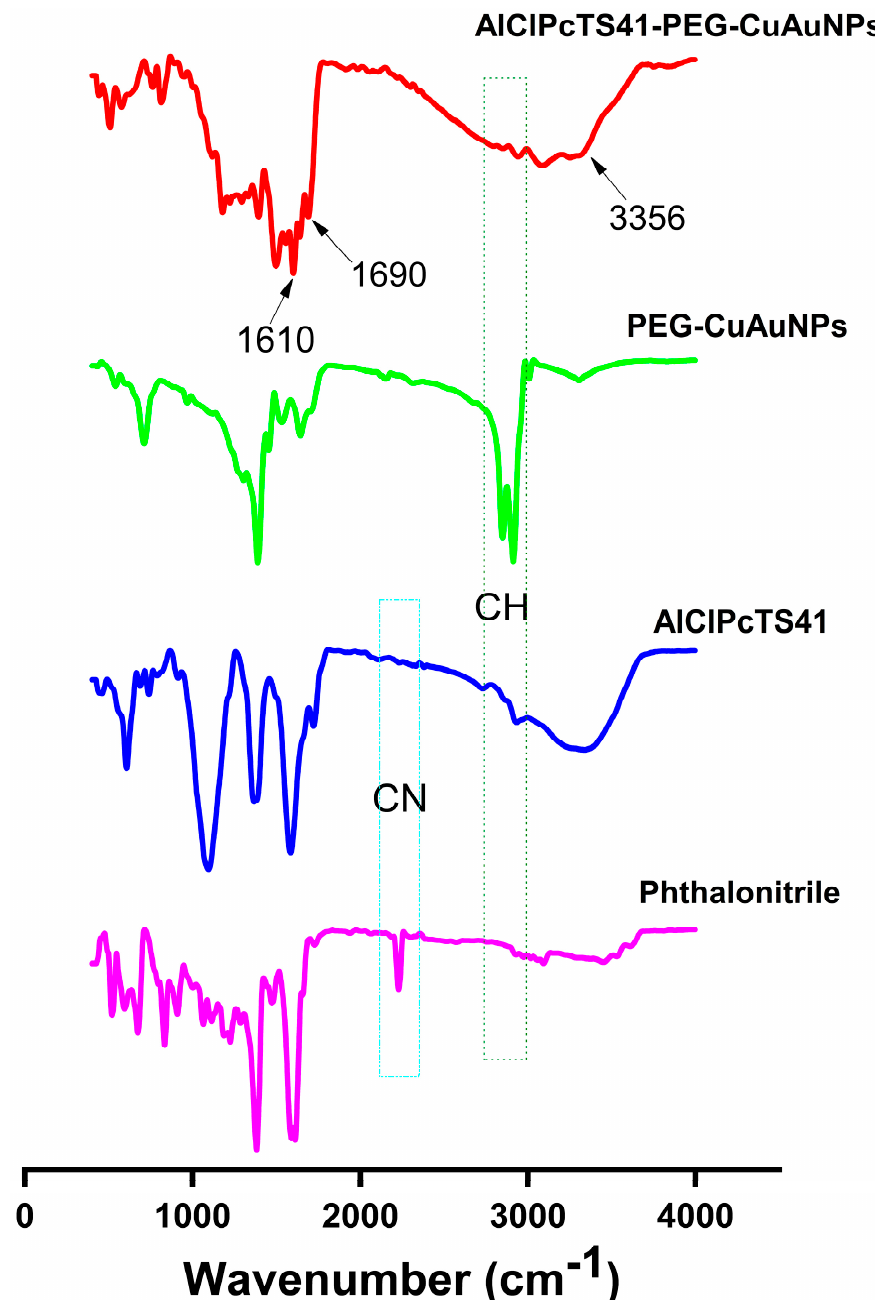
Figure 1. Fourier-transform infrared spectroscopy of the chemically linked AlClPcTS41-PEG- CuAuNPs compared to the AlClPcTS41 and PEG-CuAuNPs alone.